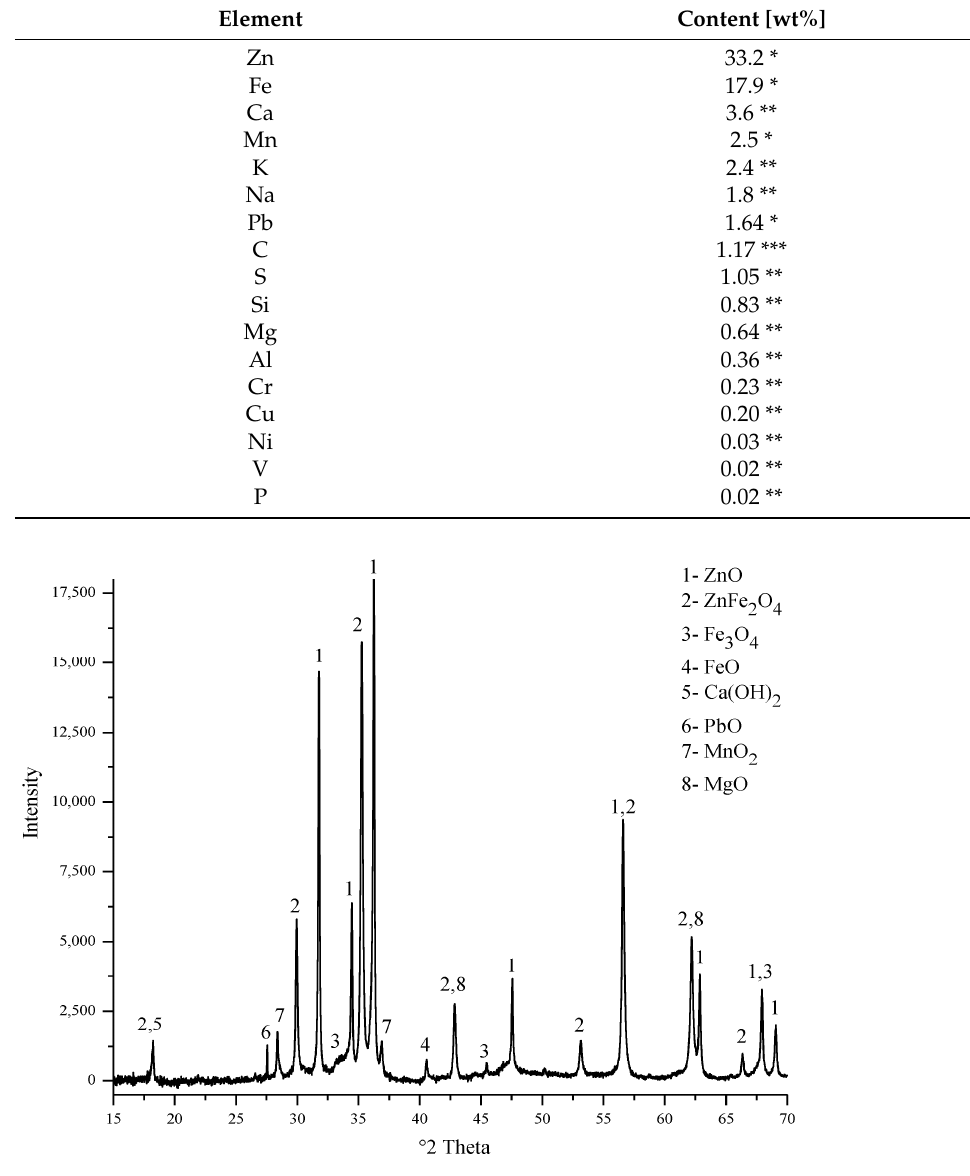
Figure 2. XRD pattern (mineral phase) of the EAFD.